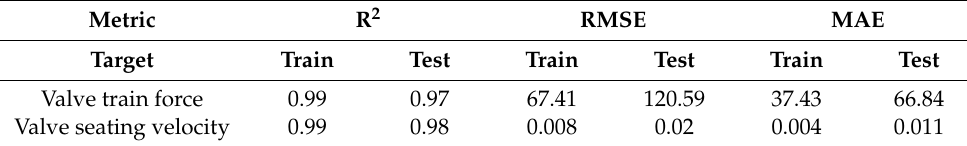
Table 4. The performance evaluation results of the GBRT prediction model.